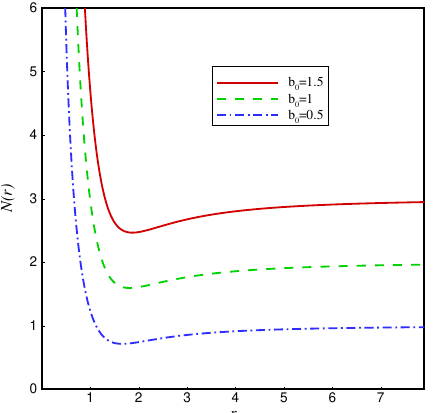
Figure 7 . The behavior of N ( r ) for rotating black hole in 3D with different J , where we have taken l = b 0 = 1 and M = 2 .